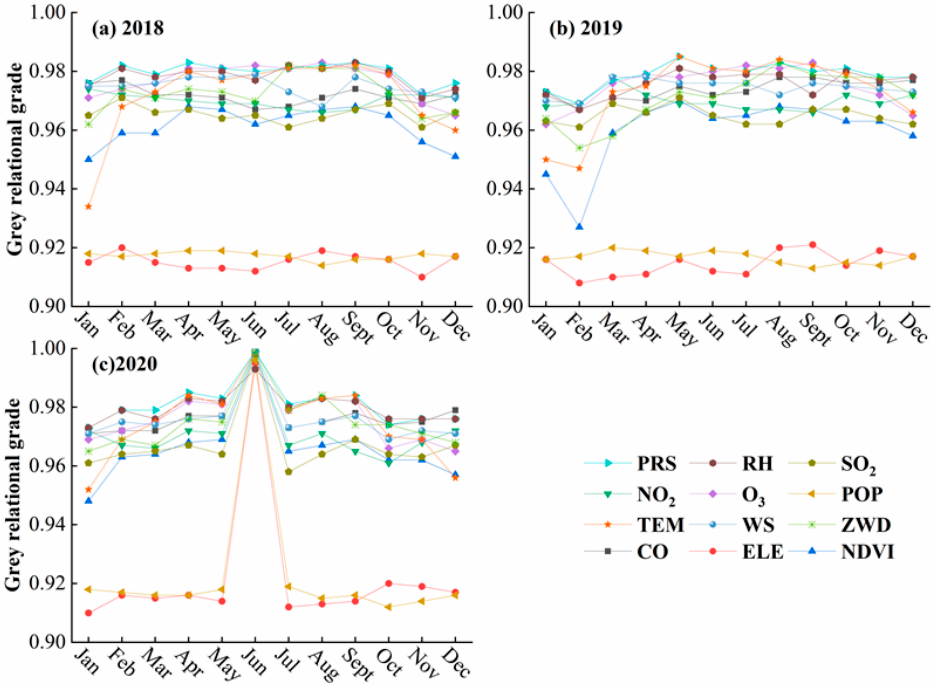
Figure 4. Results of gray relation analysis for each month of ( a ) 2018, ( b ) 2019, and ( c ) 2020, with points of different shapes and colors indicating the gray relational grade between PM 2.5 and different explanatory variables.